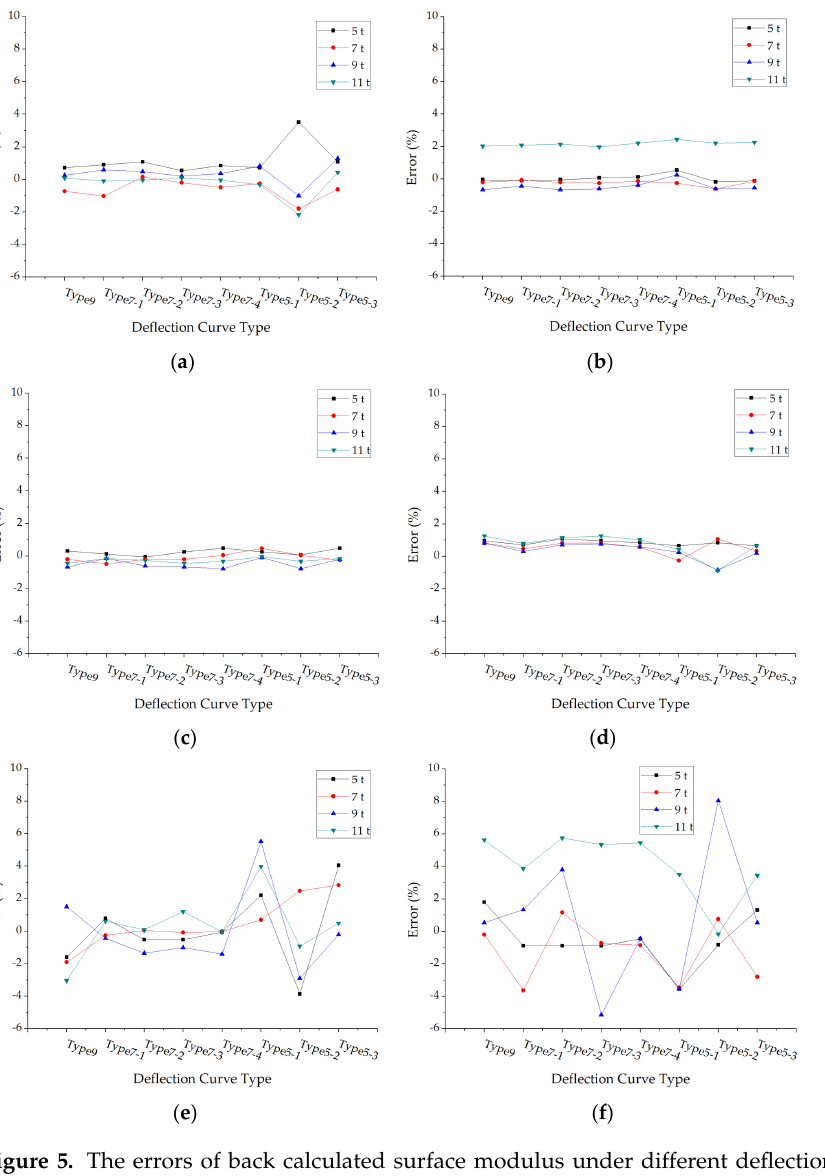
The average absolute values of surface modulus errors under different deflection curve types and axle loads were calculated and drawn in Figure 6. The average back calculation errors of the surface layer modulus fluctuate in a small amplitude under dif- ferent forms of deflection curves, which means the accuracies of this new back calcula- tion method are almost not affected by the forms of deflection curves. However, the er- rors decrease first and then rise with the increase in axle load.